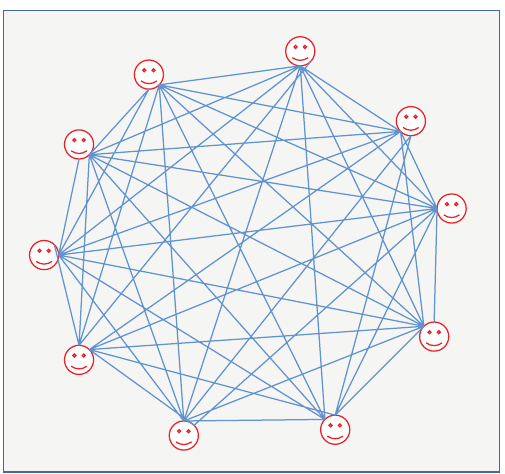
Figure 12: Random network, adapted from Savarimuthu [40].